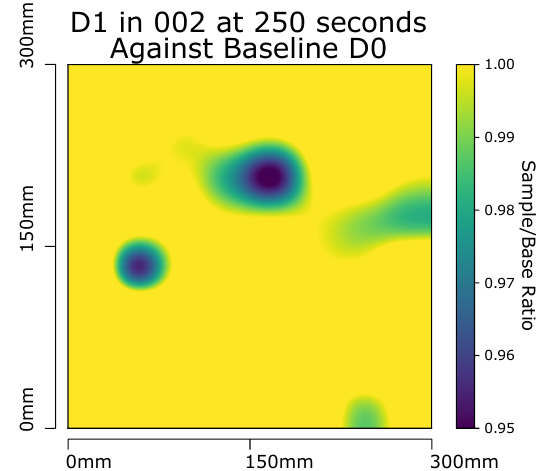
Figure 9. Panel D1 at 250 s with Gaussian interpolation applied to RTD array captured data. Each probe compared against corresponding baseline probe on D0 sample at same time and temperature. Max scale set to 1, min scale set to 0.95 (Sample/Base